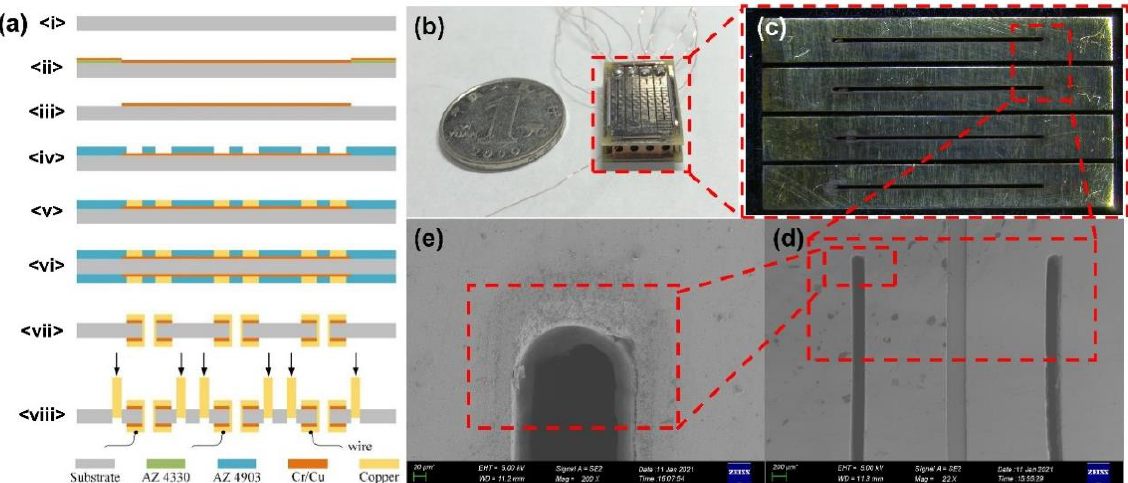
Figure 2. ( a ) Fabrication flow of MFITA. ( b ) A physical image of fabricated MFITA. ( c ) A top-view optical image of the MFITA. ( d ) A SEM image of ion exit slot. ( e ) Enlarged details for ( d ).